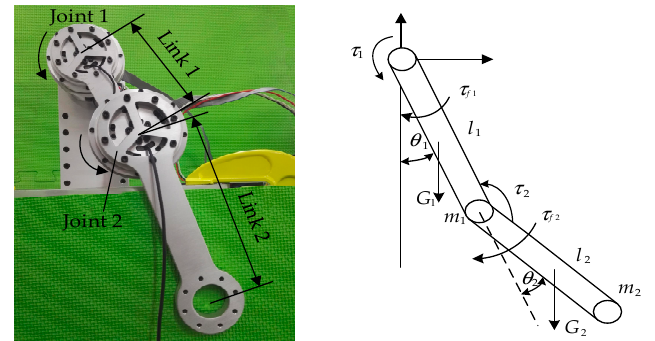
Figure 3. Prototype and simplified model of the two degrees-of-freedom (2-DOF) robot.